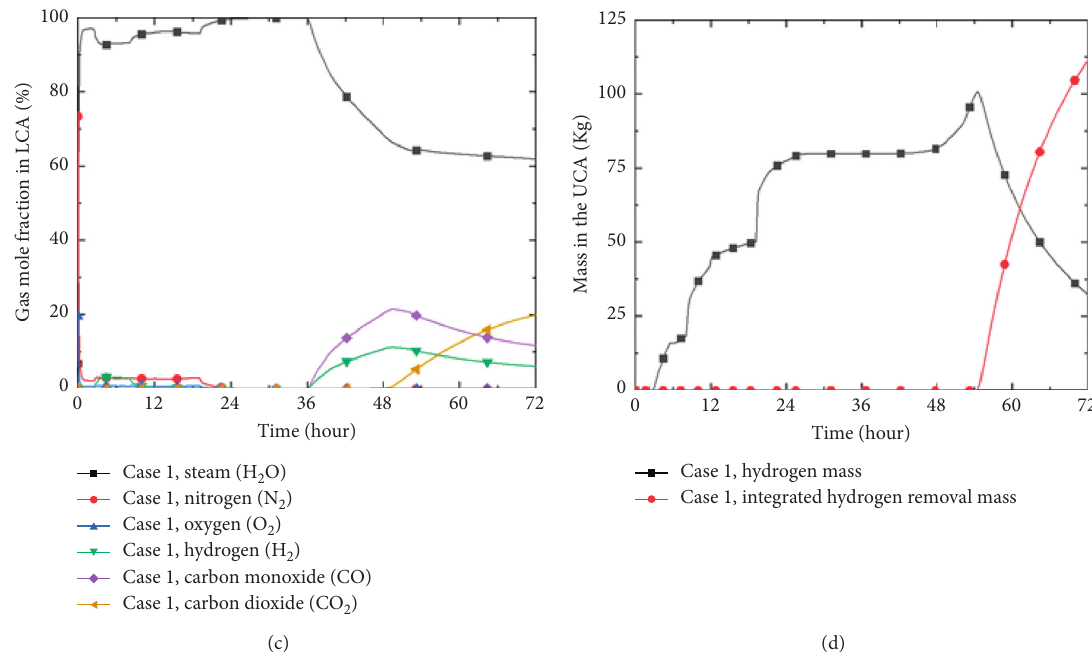
Figure 6: Containment properties from the MELCOR analysis: (a) pressure, (b) hydrogen mole fraction, (c) gas mole fraction in the lower containment area, and (d) hydrogen mass and integrated hydrogen removal mass in the upper containment area.